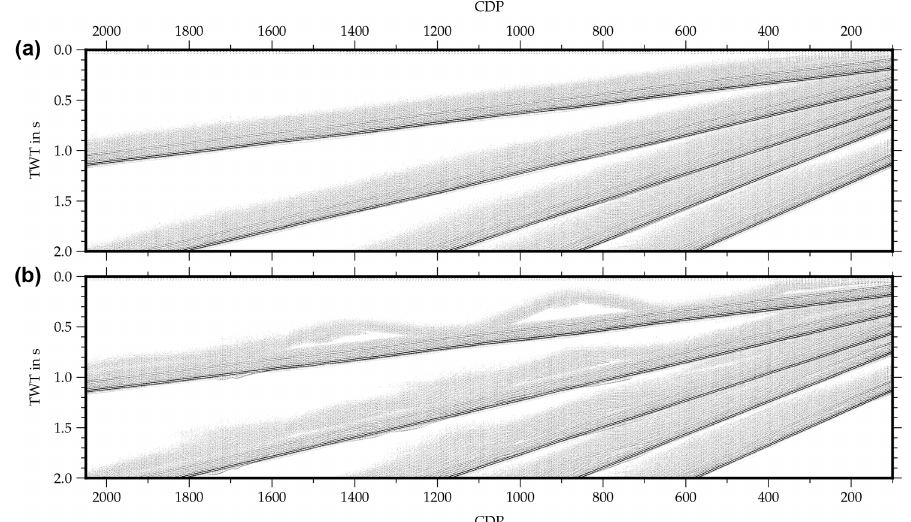
Figure 8. Results of the third synthetic model with reflectors dipping in the inline and cross-line direction. Comparison of the stacked section with cross-dip correction before DMO correction (a) and with cross-dip correction applied after DMO correction (b) . In both cases, the reflections become focused and flattened, but in the second case, artifacts are stronger.